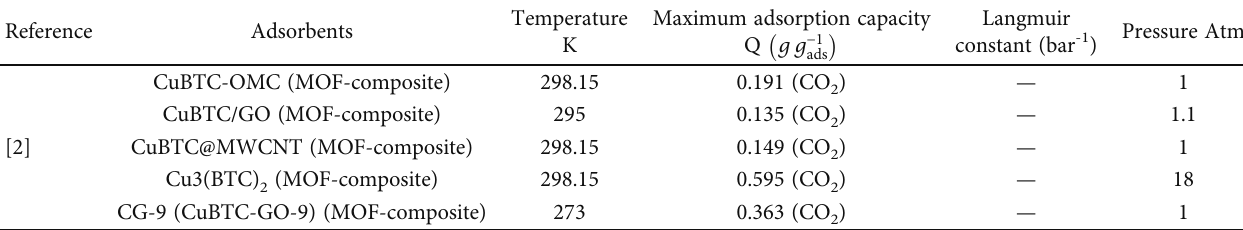
Table 9: Works reported on the di ff erent con fi gurations of PSA processes for puri fi cation of biohydrogen. Reference